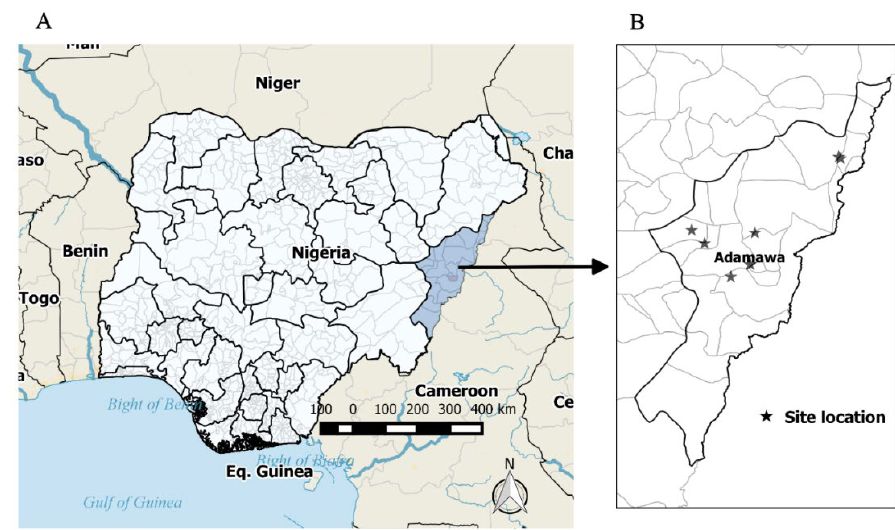
Figure 1. ( A ) Map of Nigeria showing the study sites in Adamawa state; ( B ) Study sites.